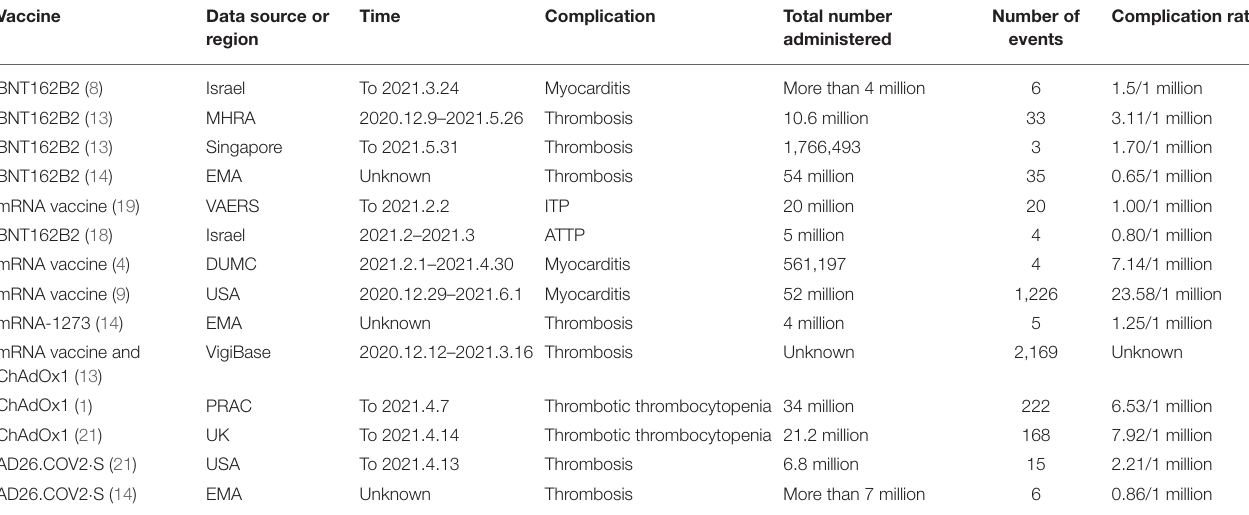
TABLE 1 | Cardiovascular complications of coronavirus disease 2019 (COVID-19) vaccines. Vaccine Data source or